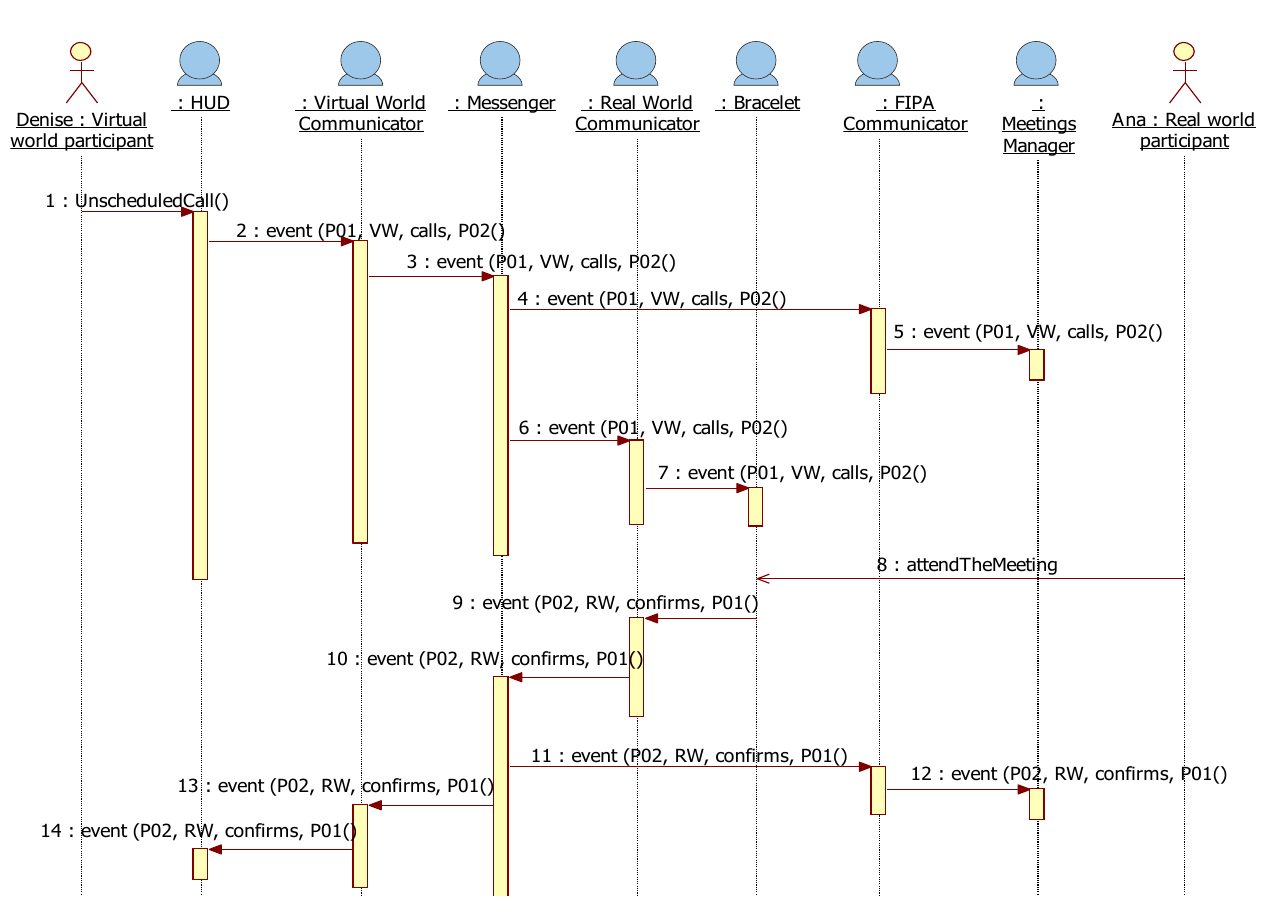
Figure 9. AML Sequence Diagram of an unscheduled meeting